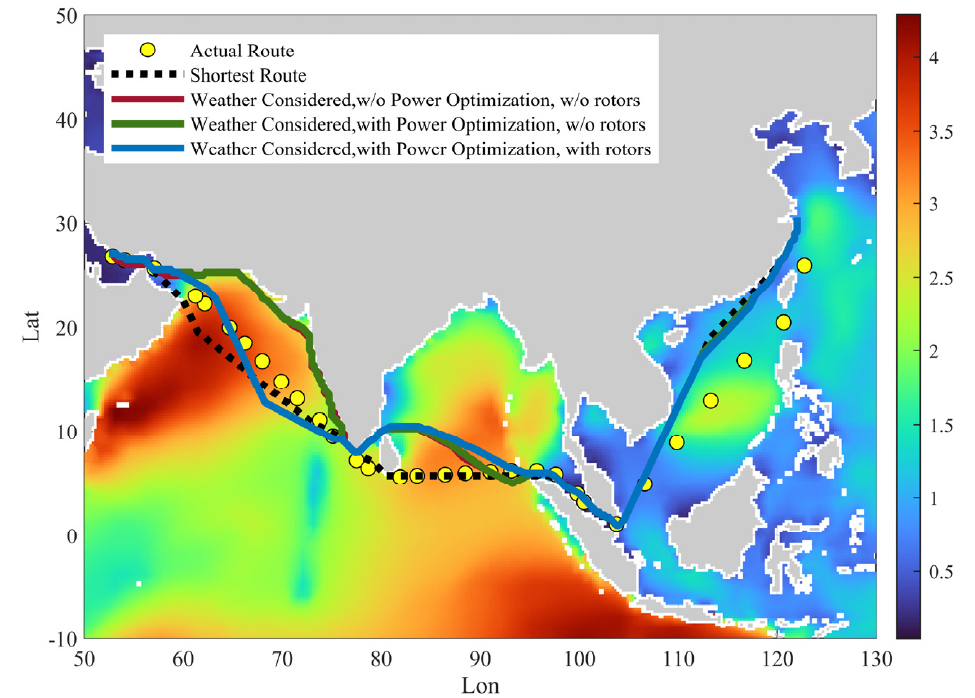
Figure 21. Result for ship weather routing for Case 8.